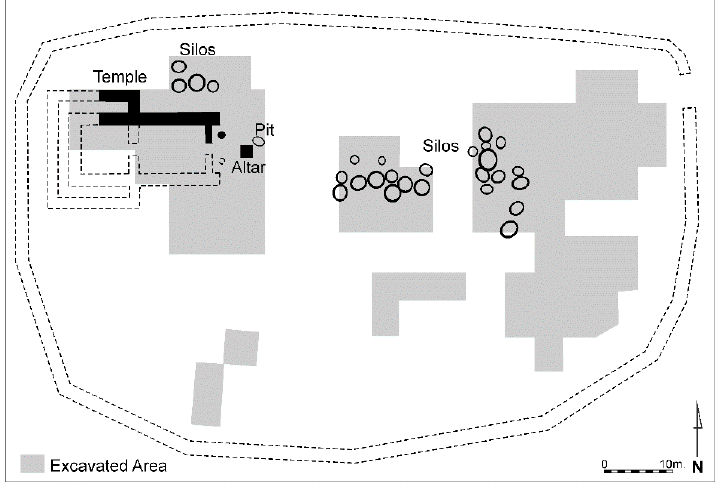
Figure 4. Schematic plan of the administrative compound at Motza. The excavated areas are shown in gray, and include the silos and the temple. It is likely that the entire complex was surrounded by a fence (based on Greenhut and De Groot 2009; Kisilevitz 2015).